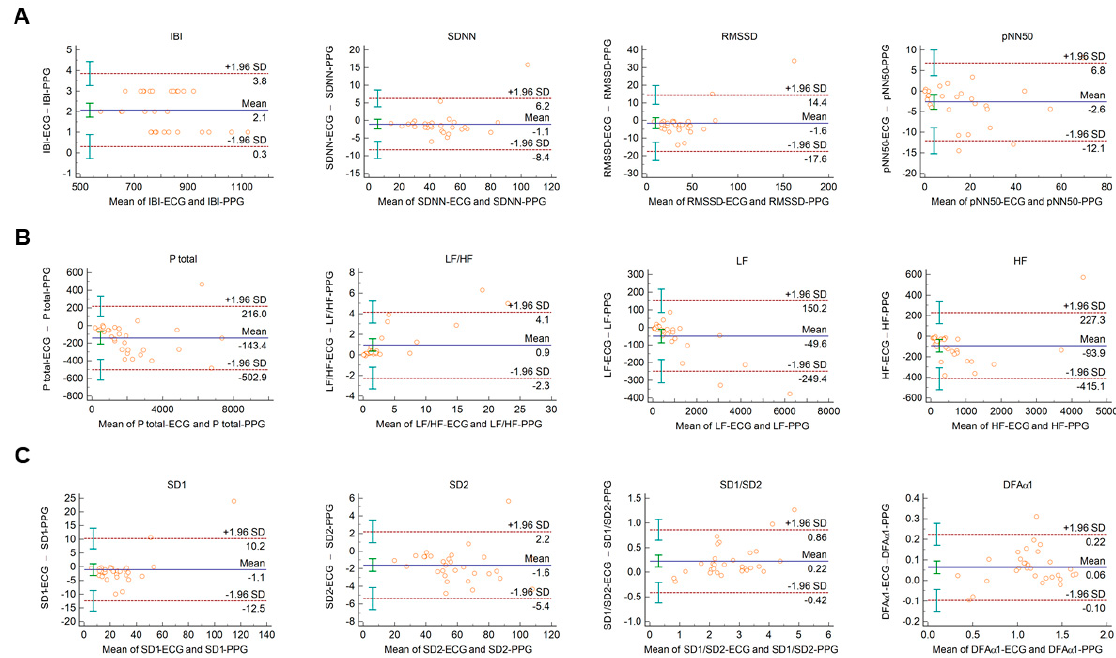
Figure 1. Bland–Altman plots of HRV/PRV parameters computed by the Kubios Premium algorithm from 2-min long ECG (indicated as ‘parameter name-ECG’) and PPG (indicated as ‘parameter name-PPG’) recordings captured under resting conditions. ( A ) Time-domain parameters: IBI (interbeat interval), SDNN (the standard deviation of IBIs), RMSSD (the square root of the mean squared differences of successive IBIs), pNN50 (the proportion of differences of successive IBIs exceeding 50 ms). ( B ) Frequency-domain parameters: Ptotal (total spectral power), LF/HF (ratio of low frequency to